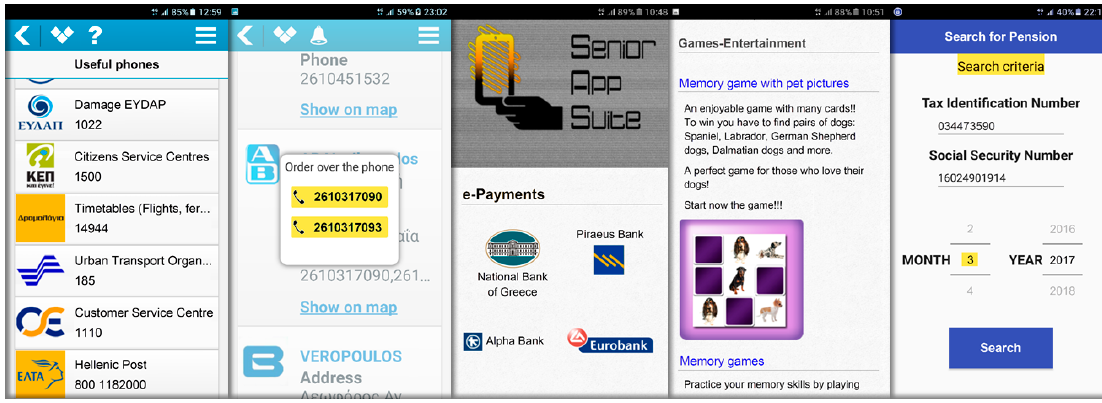
Figure 11. Screens of everyday activity facilitation services.